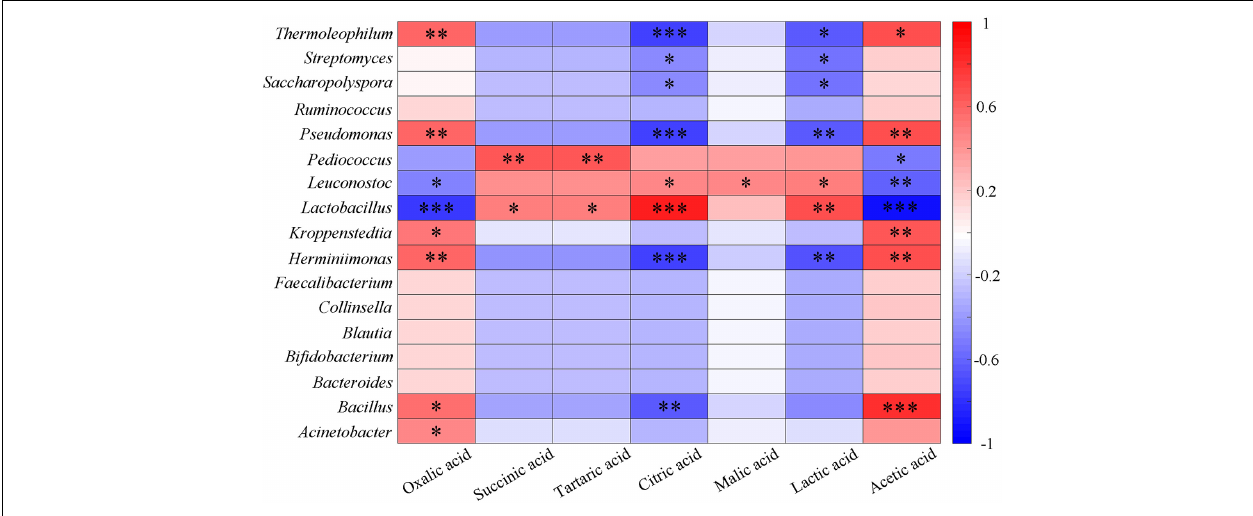
FIGURE 5 | Heatmap of correlation between organic acids and major bacteria genera of fermented grains ( ∗ 0.01 < P < 0.05, ∗∗ 0.001 < P < 0.01, ∗∗∗ P < 0.001).